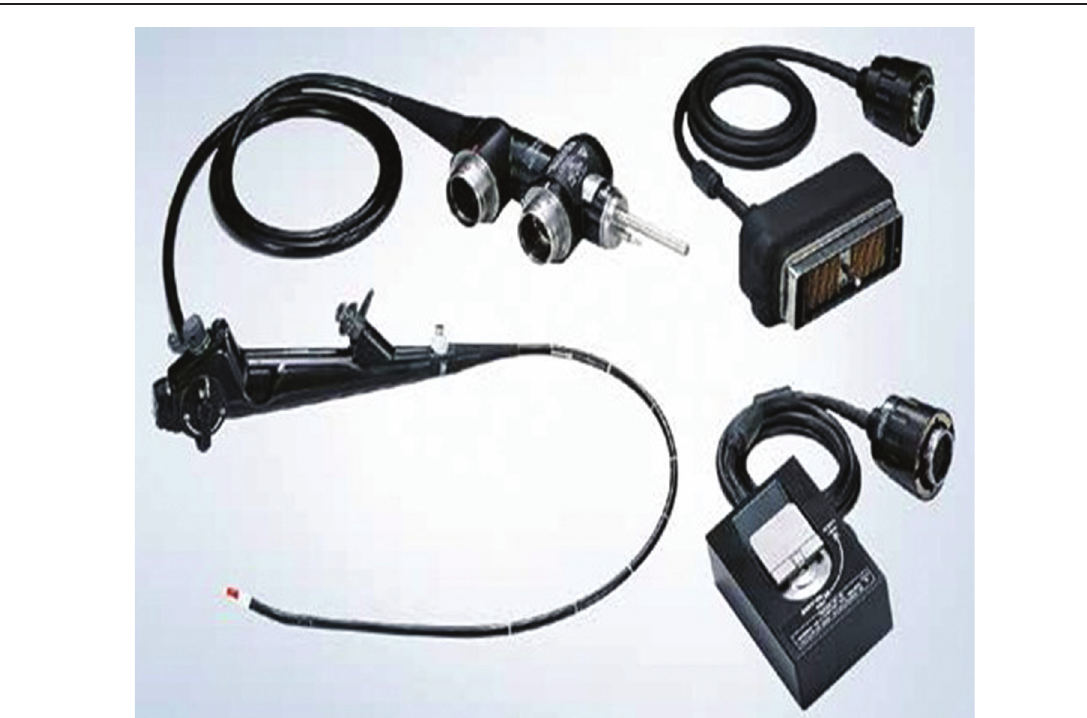
Endobronchial ultrasound convex